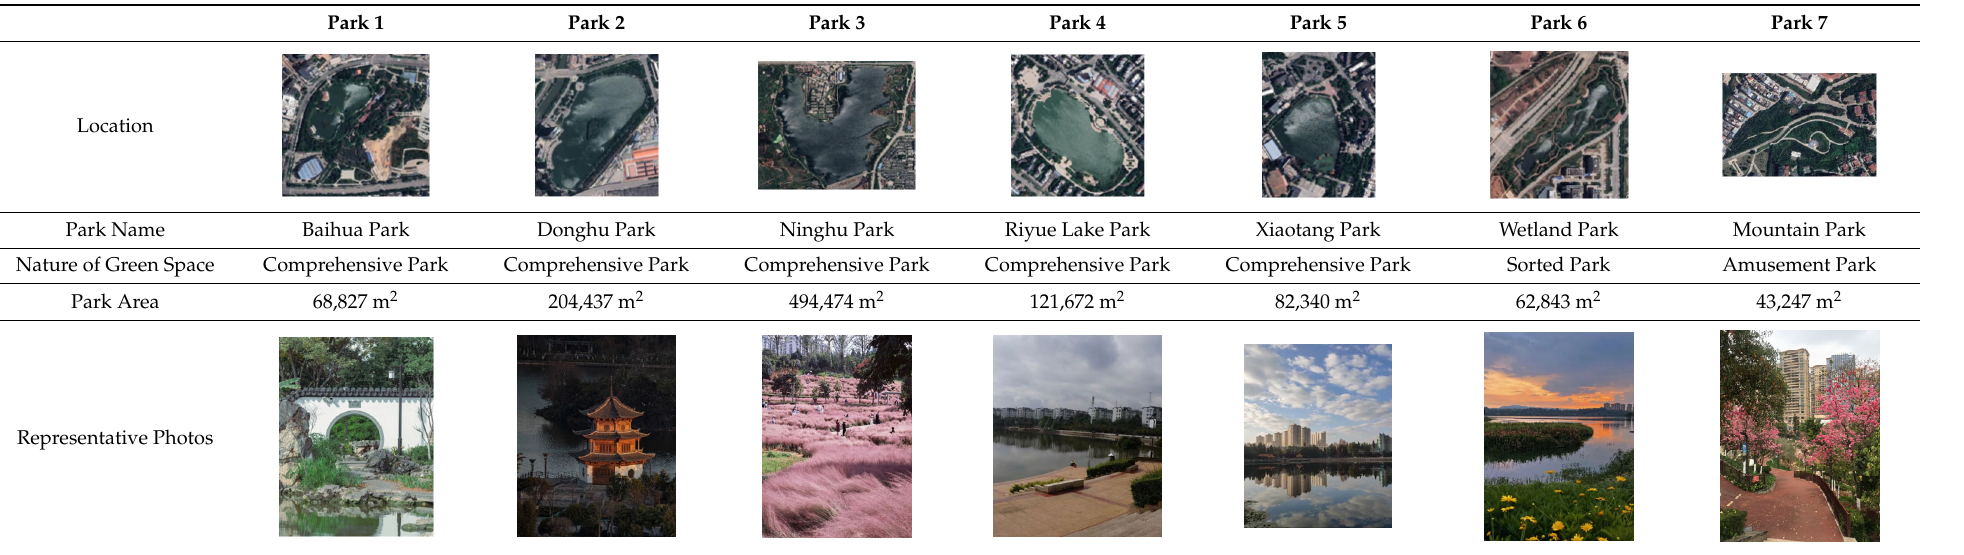
Table 2. Introduction to green spaces.